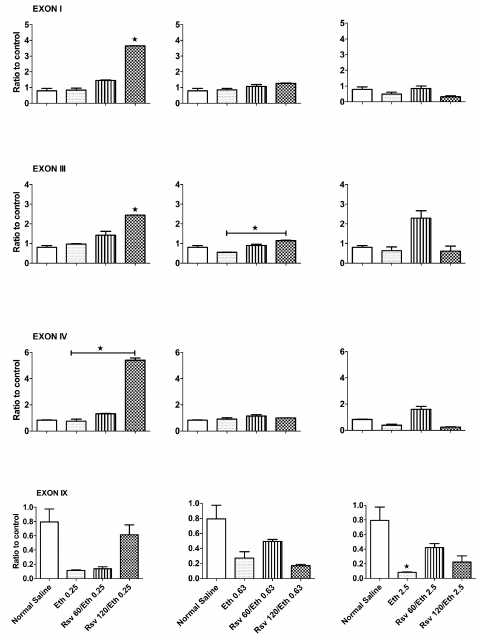
Figure 1. Eth and Rsv affect brain-derived neurotrophic factor (BDNF) exon expression in the hippocampus of pregnant rats differently. Eth had no significant effect on expression of any of the BDNF exons except at a dose of 2.5 g/kg·BW/day, which caused a decreased in the expression of BDNF exon IX ( p < 0.05). Higher doses of Rsv in combination with Eth (0.25 g/kg·BW/day) significantly increased the expression of the BDNF exons I and III compared to the normal saline group and also increased expression of the BDNF exon IV compared to the Eth group ( p < 0.05). Rsv in combination with Eth (0.63 g/kg ¨ BW/day) significantly increased expression of BDNF exon